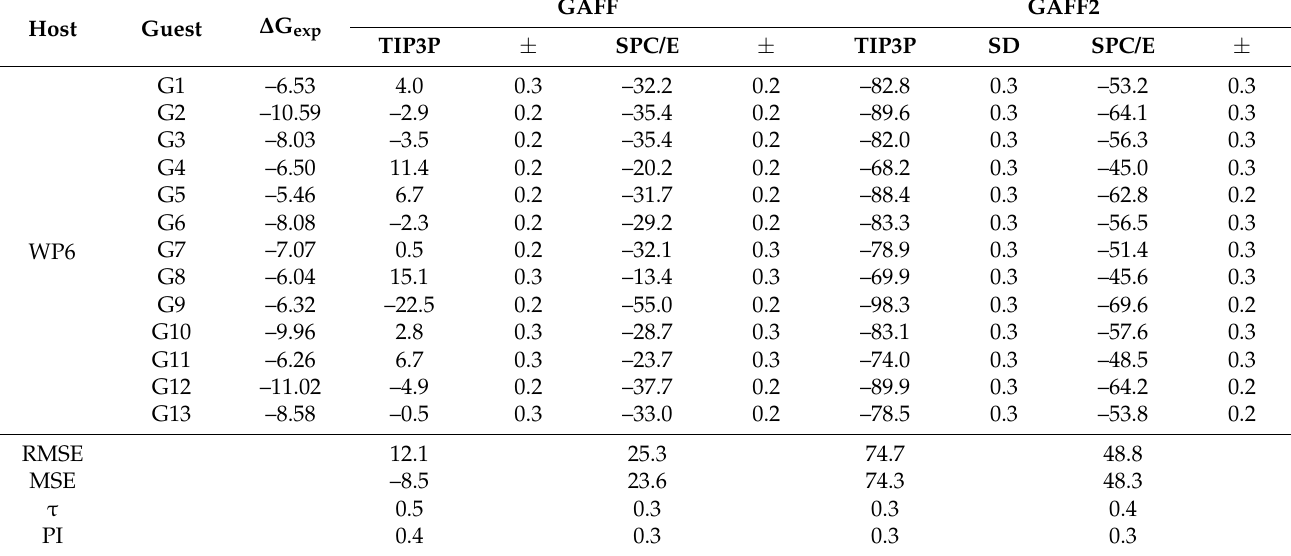
Table 4. Three-trajectory MM/GBSA end-point estimates. MSE, RMSE, τ , and PI serve as